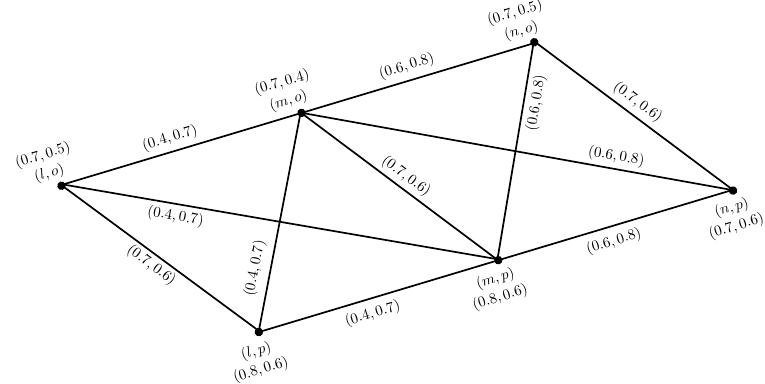
Figure 7. Strong product of two